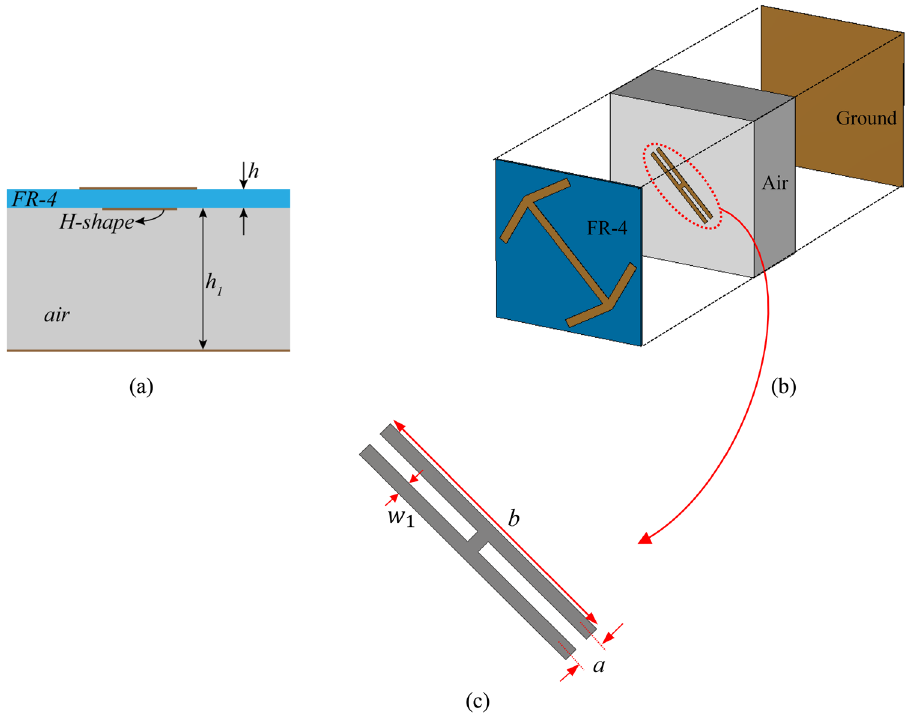
Figure 6. ( a ) Side view of the proposed unit cell, ( b ) the composition of proposed unit cell ( c )